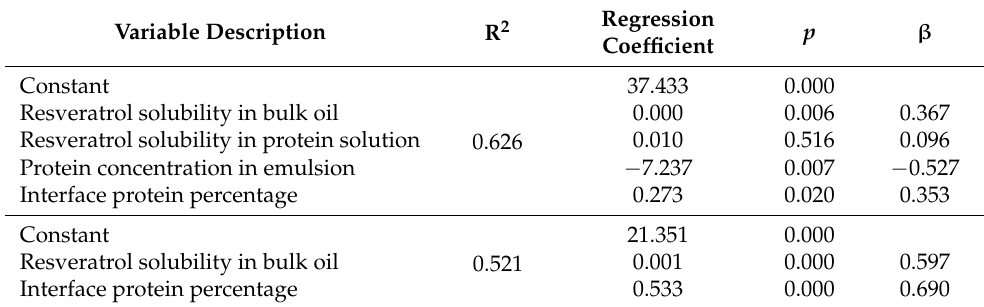
Table 5. Multiple linear regression analysis of the percentages of resveratrol at the oil–water interface of fish oil, sunflower oil, MCT and peppermint oil